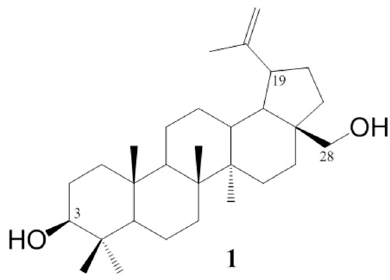
Figure 1. Chemical structure of betulin .